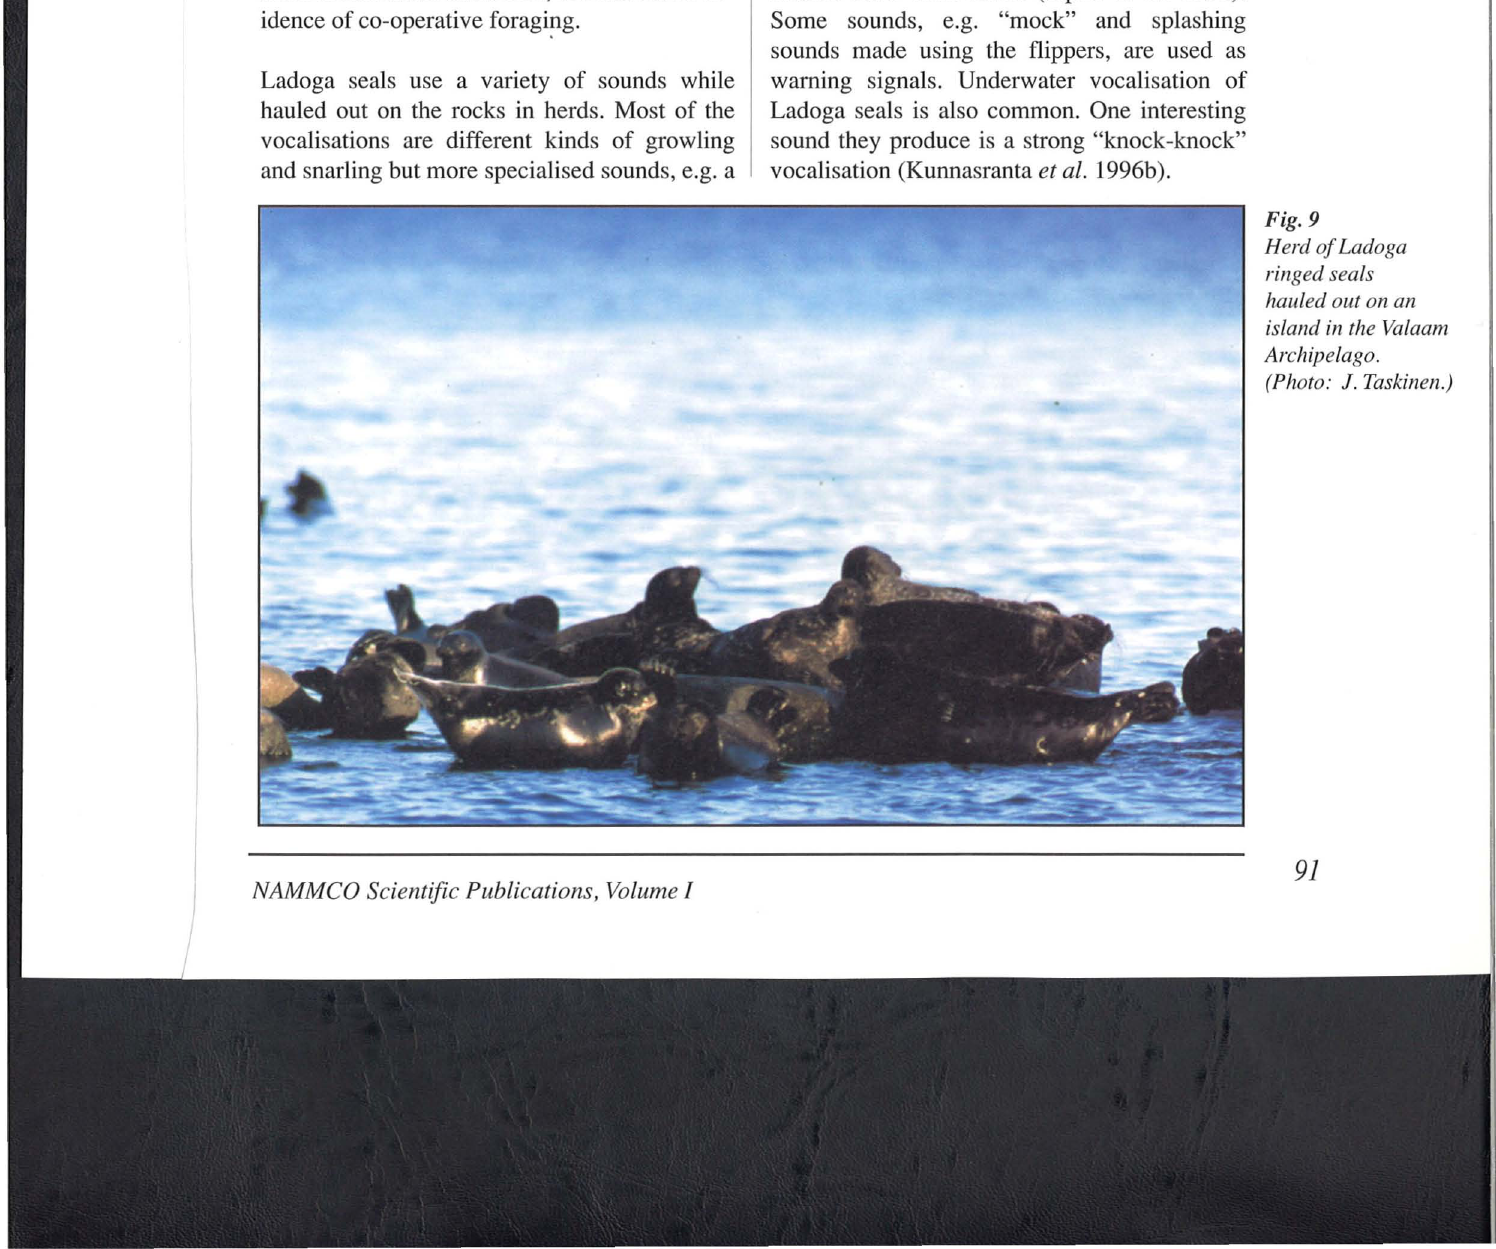
Fig. 9 Herd of Ladoga ringed seals hauled out on an island in the Valaam Archipelago. (Photo: 1.